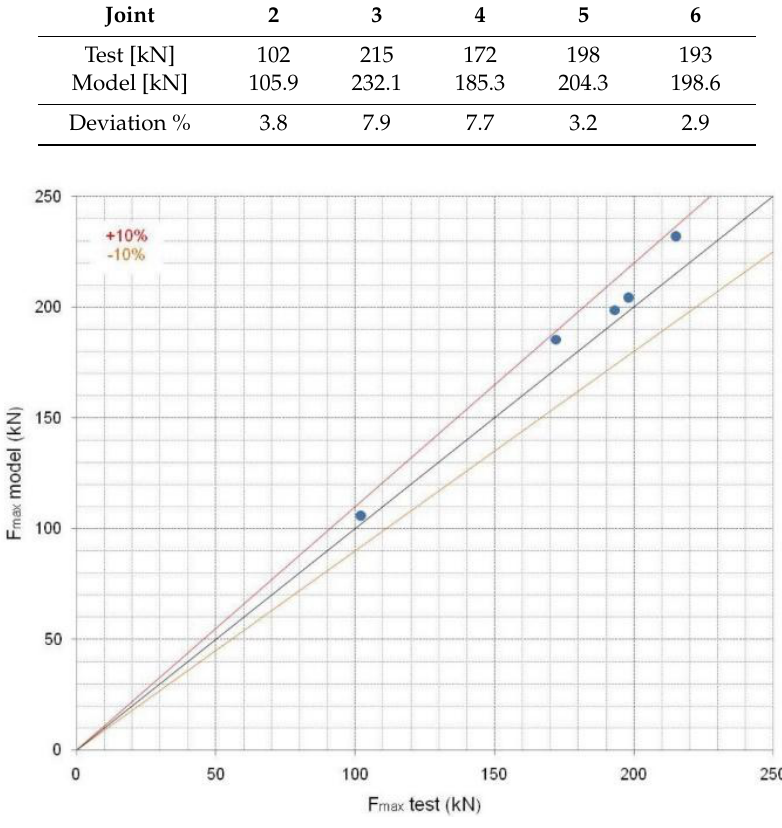
Figure 9. Model vs. tests for 2nd Figure 9. Model vs . tests for 2nd validation.